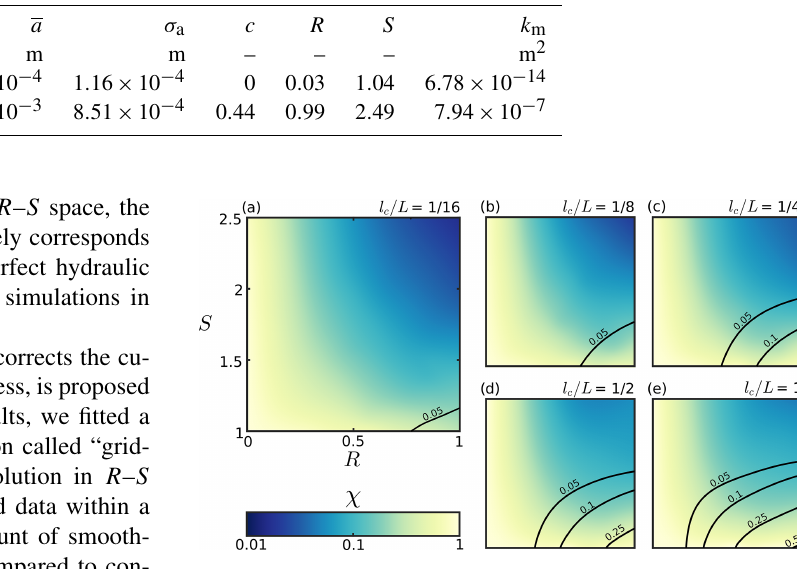
Figure 5. The distribution of the hydraulic efficiency χ for dif- ferent l c /L ratios as a function of R and S . Both axes limits in panel (a) correspond to panels (b) – (e) . Dark blue color indicates poor hydraulic efficiency, whereas lighter color shows increasing accordance with the cubic law. The black contour lines indicate the absolute residuals to the fitted surface (compare with Fig.